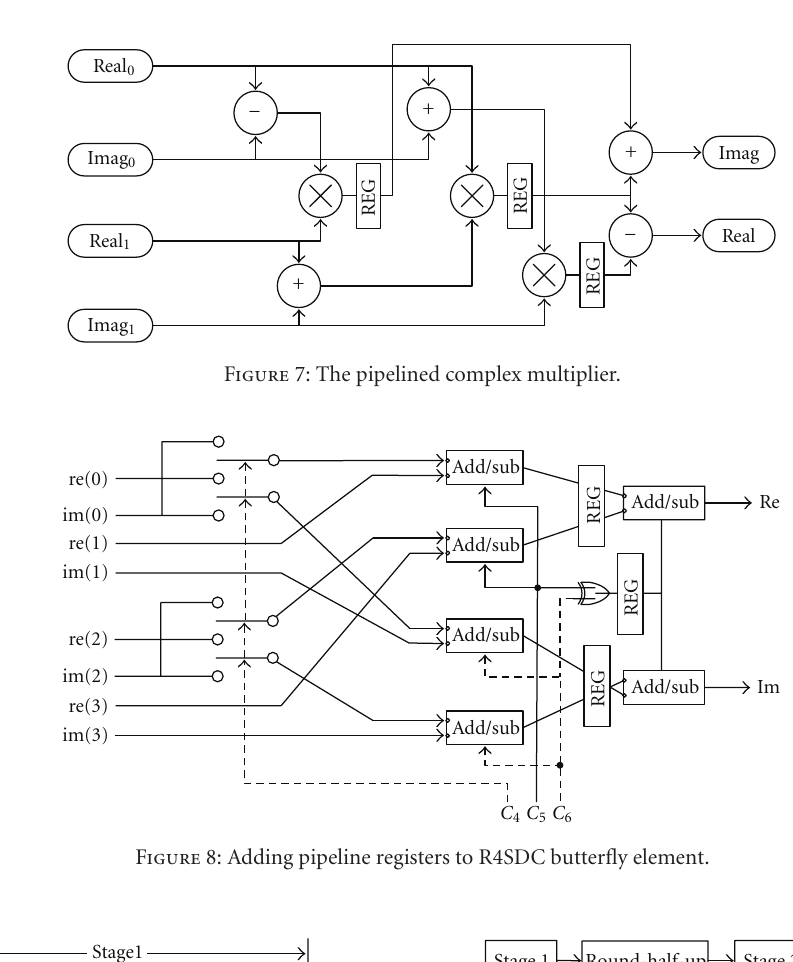
Figure 11: Balanced stages rounding.